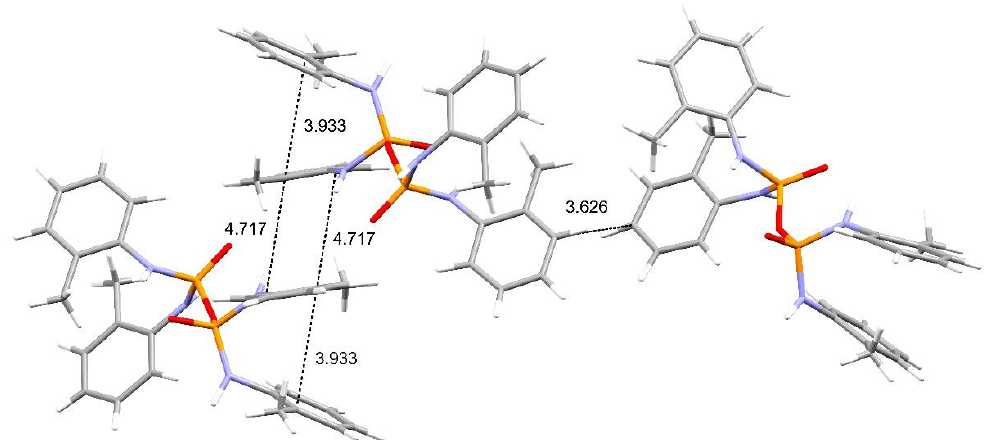
Figure 7. O((2-MePhNH) 2 PO) 2 polymorph published by Cameron et al. showing both intermolecular and intramolecular C–H ··· Ph interactions (generated in Mercury [25]).